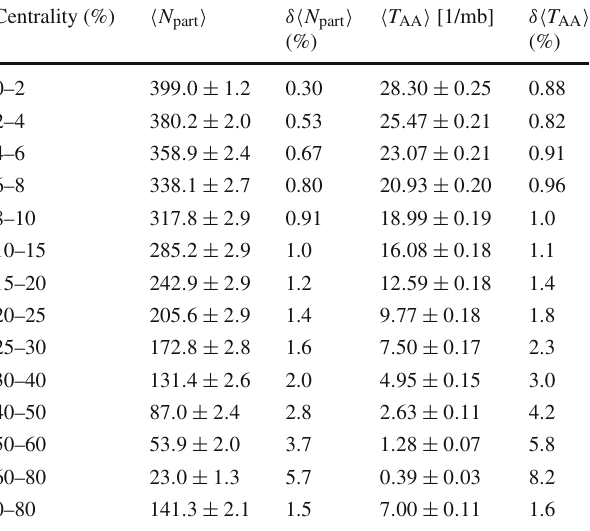
Table 1 Geometric parameters extracted from the MCGlauber code v2.4 for different centrality classes in 2015 Pb + Pb data. Average numbers of inelastically interacting nucleons (cid:4) N part (cid:5) and mean values of the nuclear thickness function (cid:4) T AA (cid:5) are listed with their absolute and relative uncertainties Centrality (%) (cid:4) N part